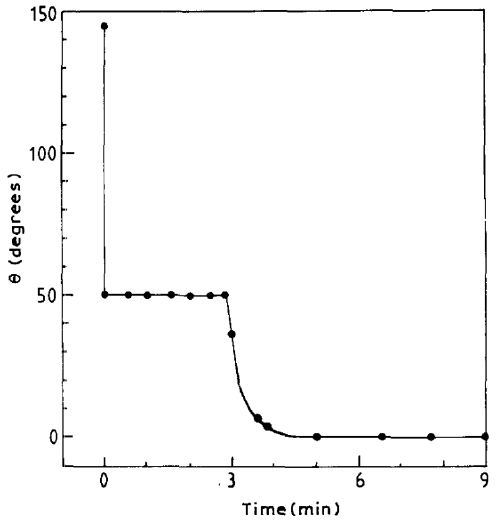
Figure 3: Contact angle, θ , of pure copper on glassy carbon versus temperature.